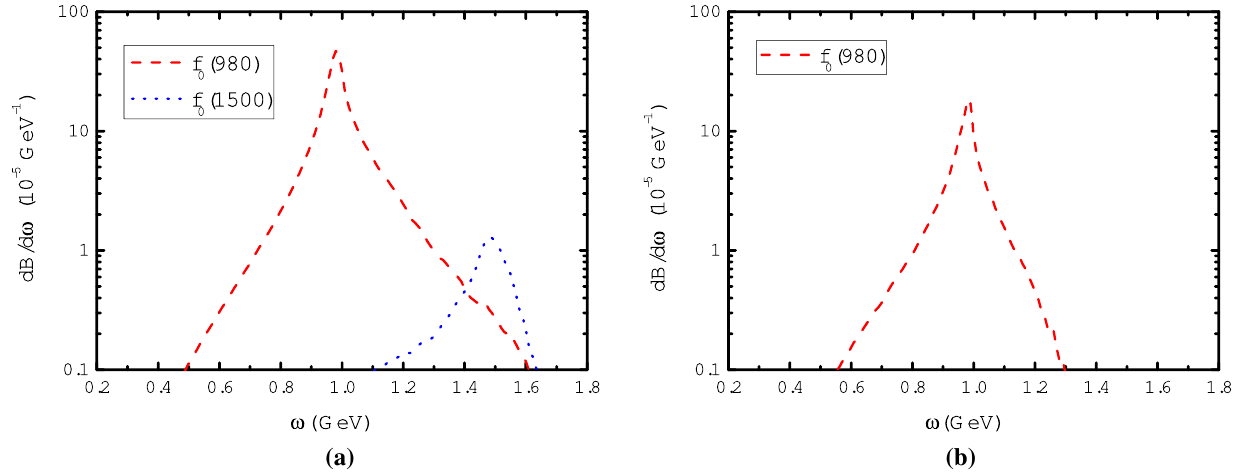
Fig. 2 a The ω dependence of the differential decay rates d B / d ω in a B 0 s → ψ( 2 S )π + π − and b B 0 s → ψ( 3 S )π + π − decays